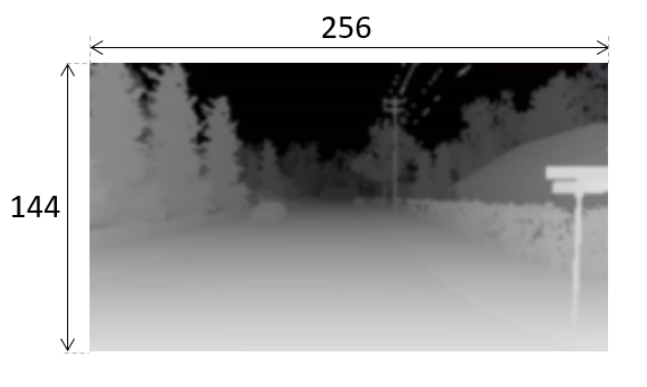
Figure 5. The Depth